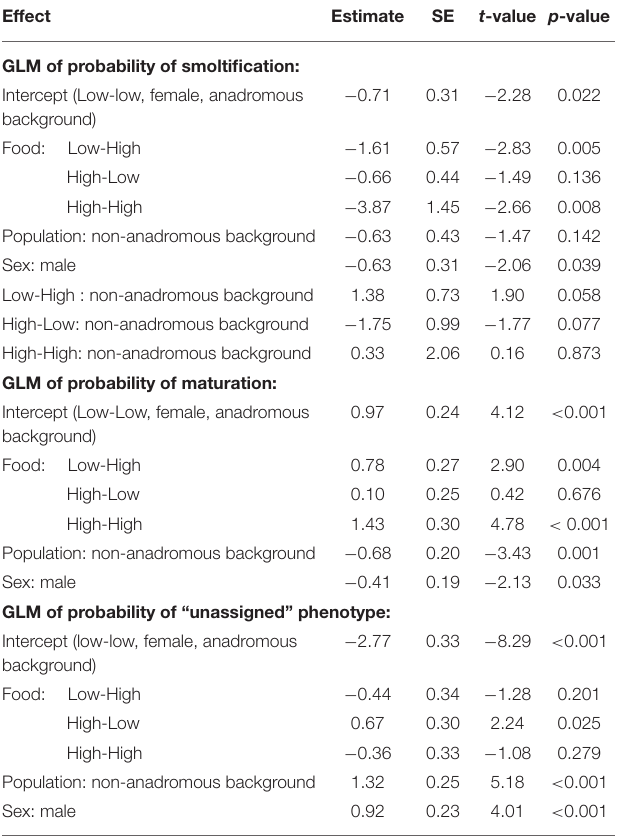
TABLE 2 | Parameter estimates with associated standard errors (SE) for two binomial generalized linear models (GLM) predicting smolt (migratory) probability (dummy coded: smolt = 1, non-smolt = 0) and freshwater maturation (dummy coded: mature/maturing = 1, immature = 0) in brown trout ( n = 567). Effect Estimate SE t -value p -value